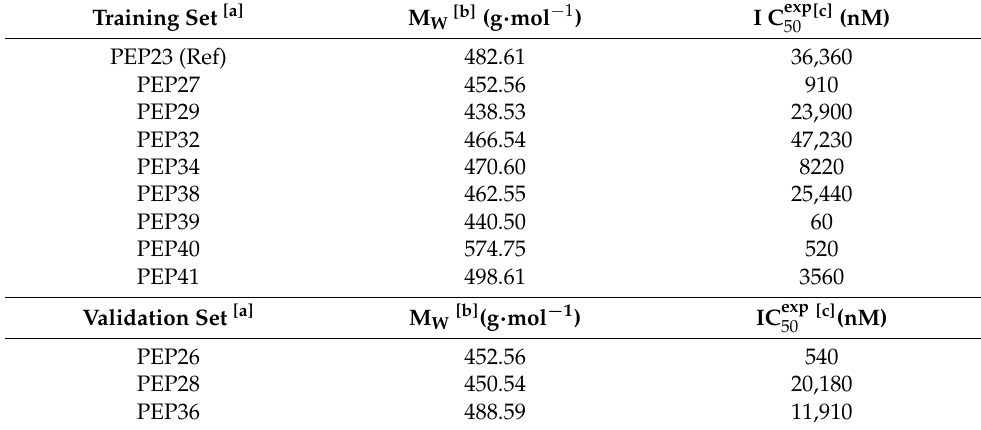
Table 1. Training and validation sets of PEP inhibitors obtained from the literature